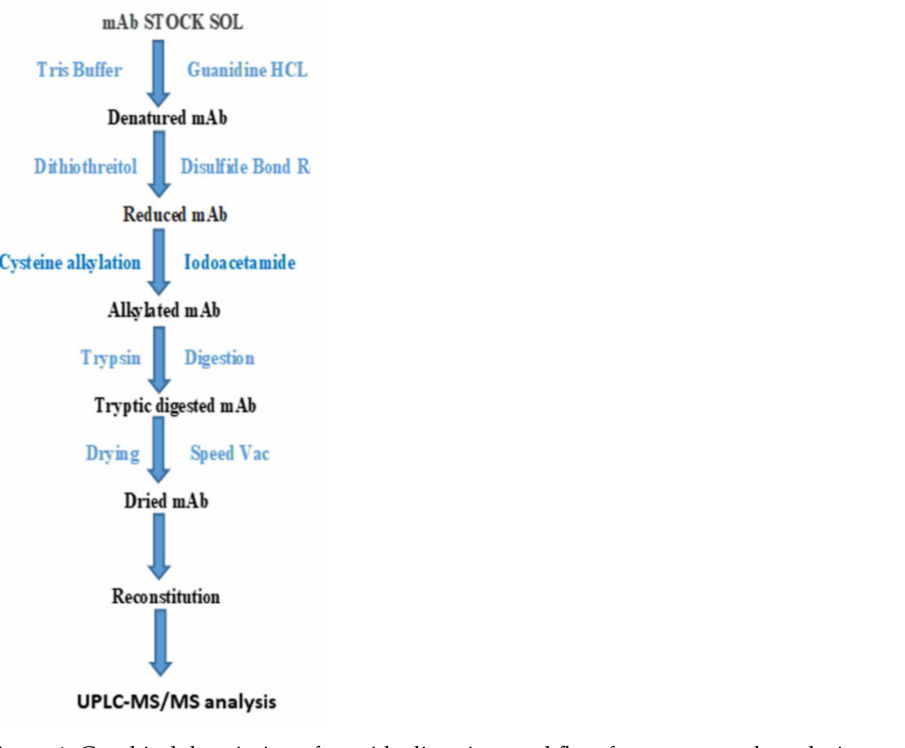
Figure 1. Graphical description of peptide digestion workflow for trastuzumab